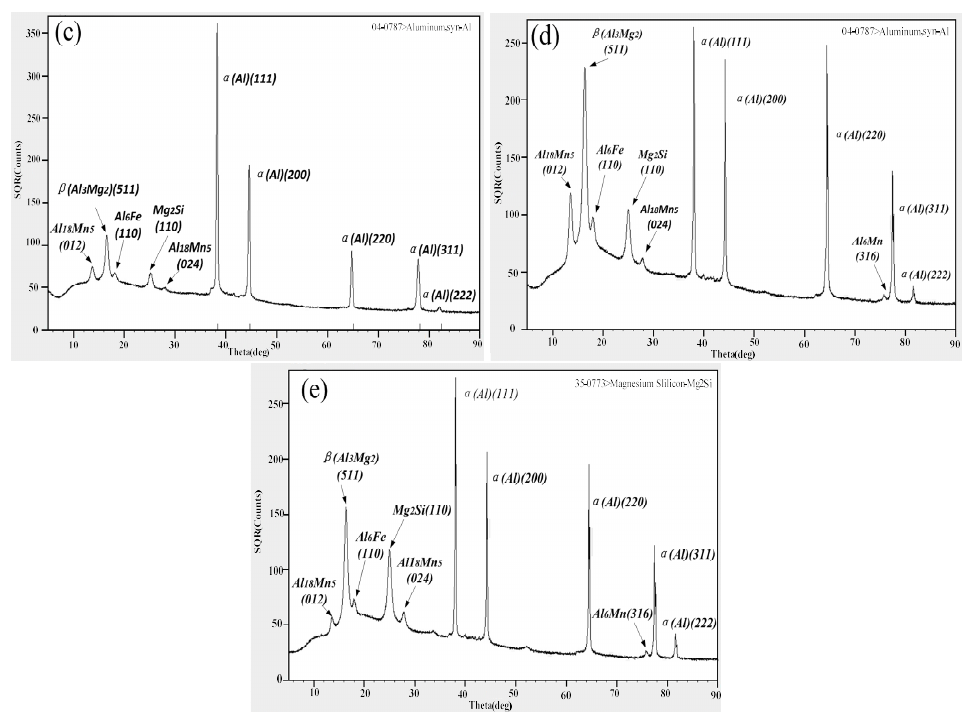
Figure 10. XRD study of the microstructure of different parts of the two alloys in the weld joint: ( a ) microstructure of the base metal (7BM); ( b ) microstructure of the heat-affected zone adjacent to the base metal (7HAZ); ( c ) microstructure of the fusion zone; ( d ) microstructure of the heat-affected zone adjacent to the base metal (5HAZ); ( e ) microstructure of the base metal (5BM).